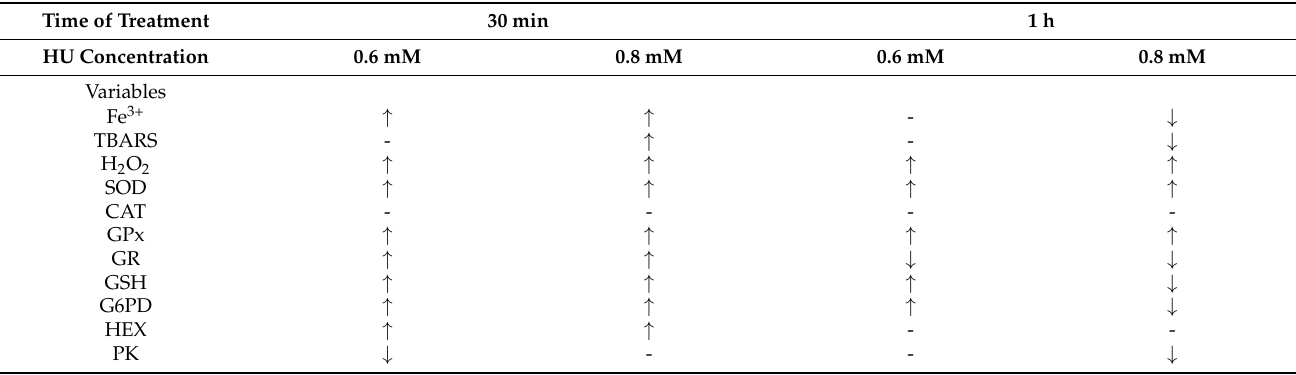
Figure 6. Enzymatic activity of the erythrocyte energy metabolism in the control samples that were treated with 0.6 and 0.8 mM HU ( n = 3) for 1 h. Hemolysate was used to measure ( A ) Glucose-6- phosphate-dehydrogenase (G6PD); ( B ) Hexokinase (Hex); ( C ) Pyruvate kinase (PK). In all of the cases, * represents a comparison between the control groups and the groups that were treated with HU (* p < 0.05 and *** p < 0.001), while ∆ represents a comparison between the groups that were treated with 0.6 and 0.8 mM HU ( p < 0.05). Table 1. Comparison of the effects of HU at different concentrations and treatment times on the erythrocytes of healthy individuals when in relation to the control